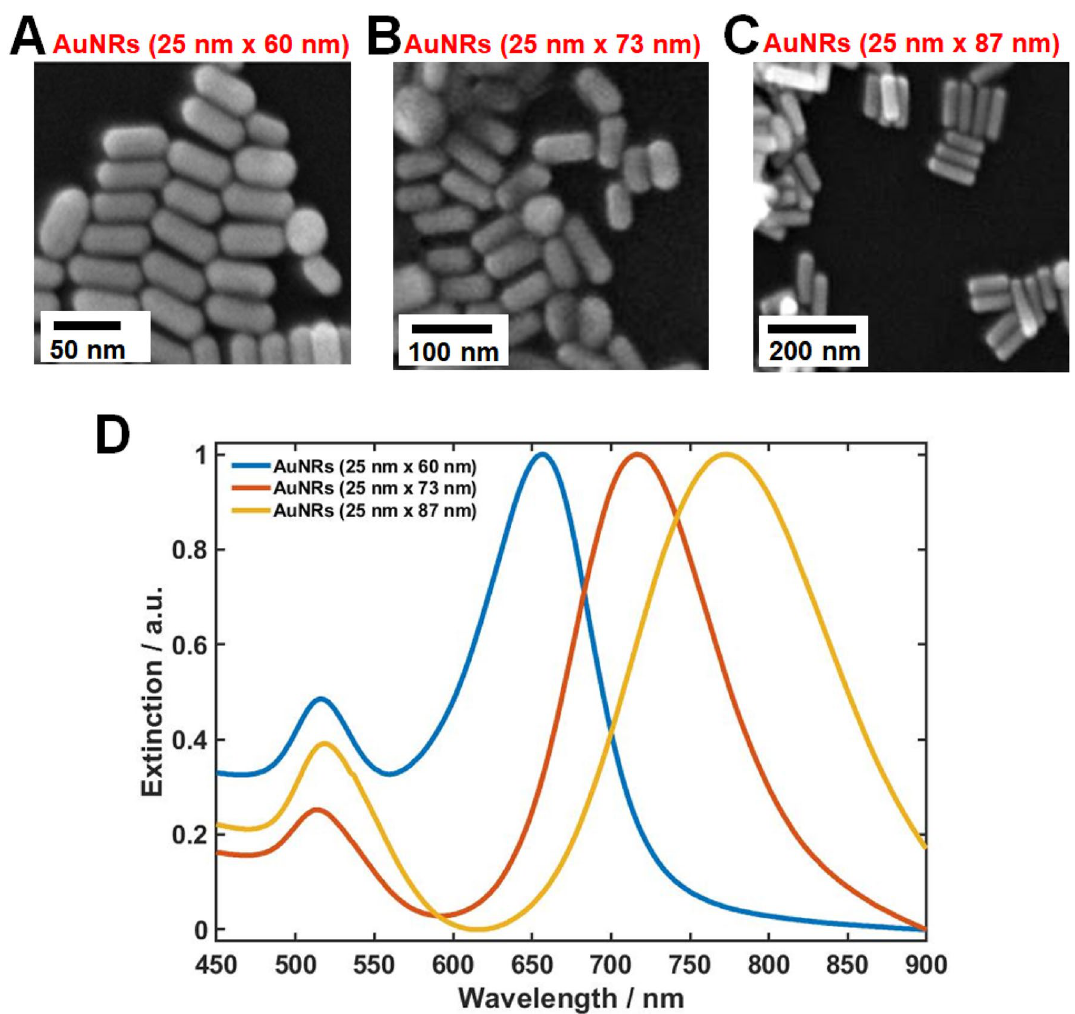
Figure 1. ( A )–( C ) SEM images of AuNRs with different aspect ratios: ( A) 2.4 (25 nm × 60 nm), ( B ) 2.9 (25 nm × 73 nm), ( C ) 3.5 (25 nm × 87 nm); ( D ) Overlaid extinction spectra of AuNRs with ARs of 2.4, 2.9, and 3.5 measured in